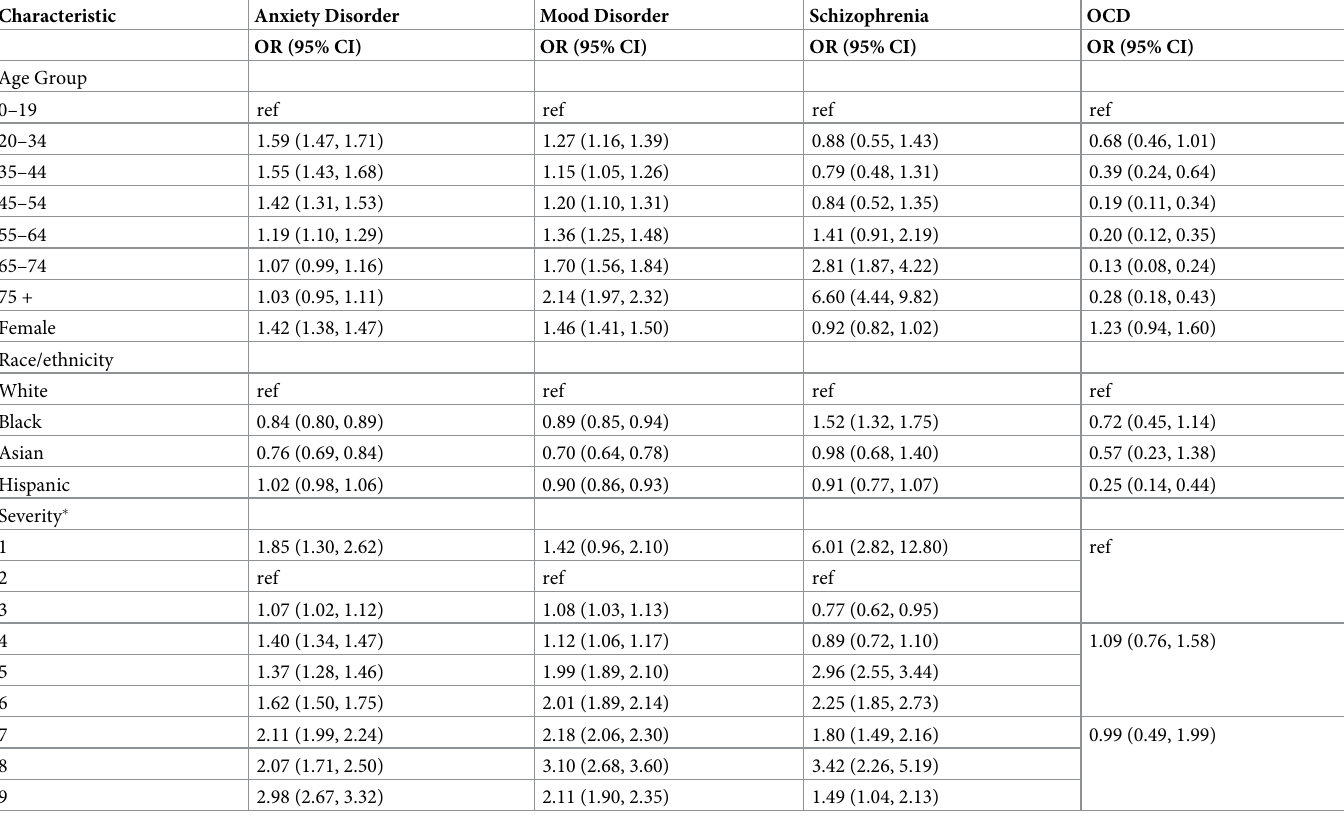
Table 3. Logistic regression of new psychiatric diagnoses and COVID-19 severity controlling for age, gender and race/ethnicity. Characteristic Anxiety